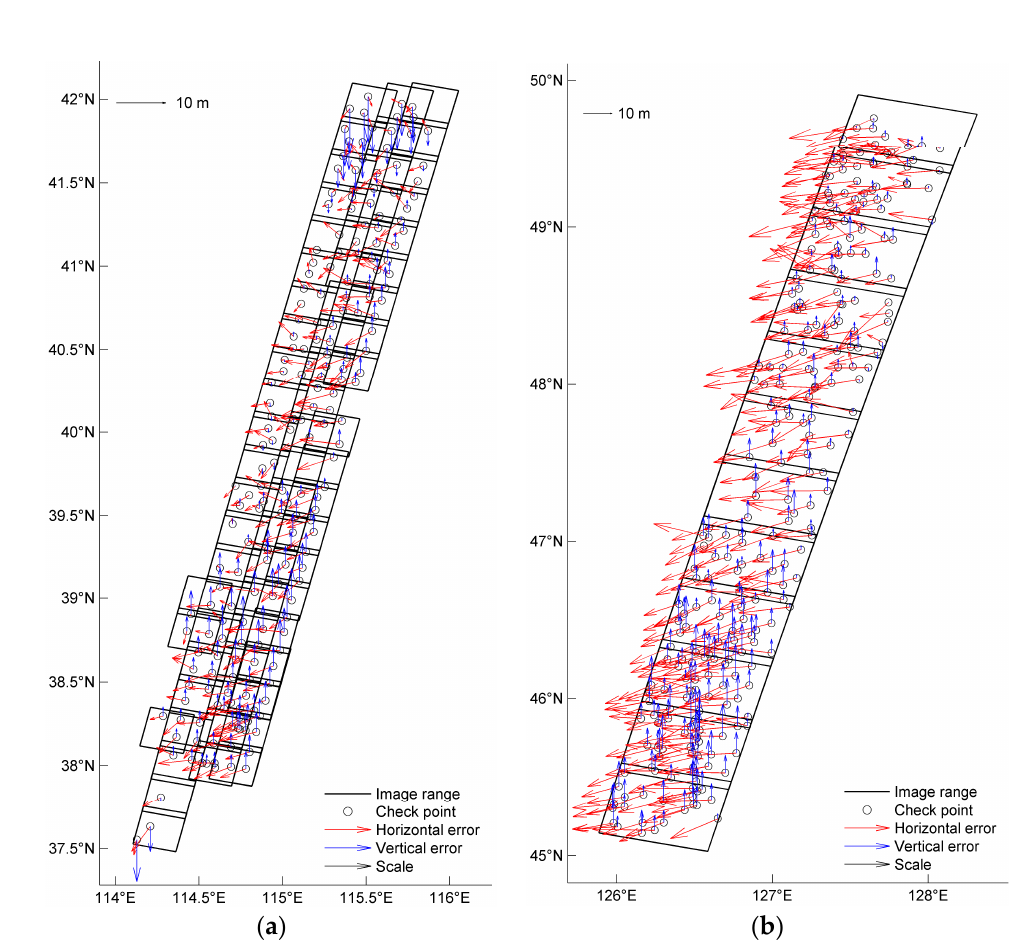
Table 3 . Accuracy requirements for 1:50,000 and 1:10,000 scale mapping in China.